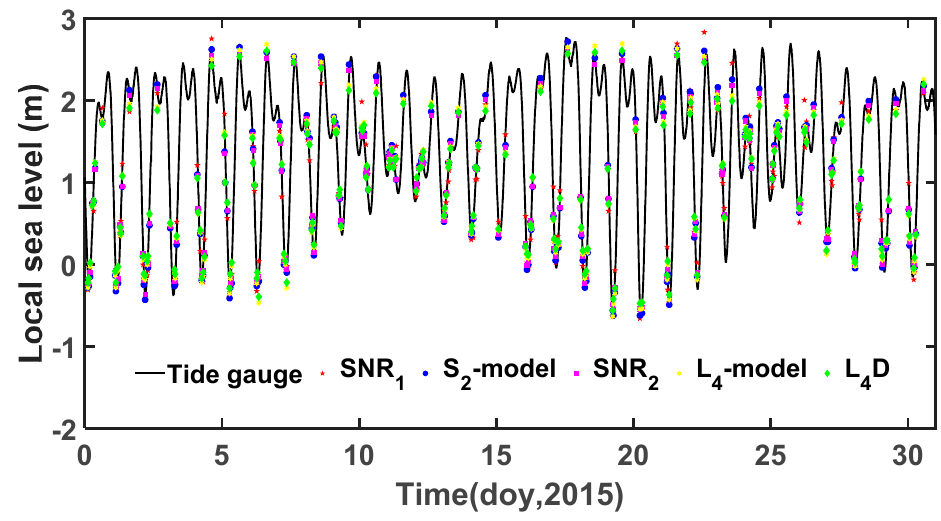
Figure 6. Sea level changes over a 31-day period, as determined from GPS L1 and L2 SNR via double-frequency combination calculated from Equation (8) and the linear model for elevation range 5–15°. Tide gauge (TG) data are also shown (black curves) for the same 31-day period, for comparison.